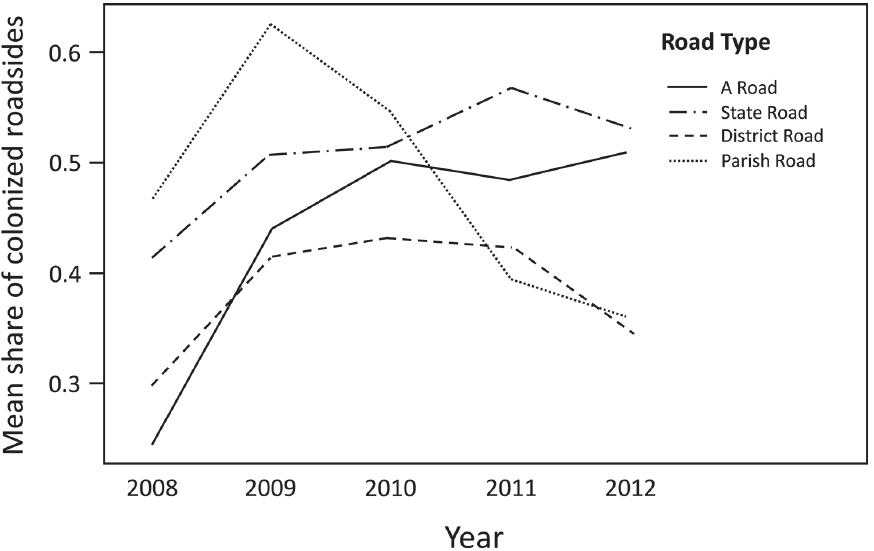
Figure 3. Proportion of roadsides in different types of road corridors, colonized by Ambrosia artemisii- folia in five years. Mean values are based on road section specific proportion of colonized road cells (n = 49 road sections in the road